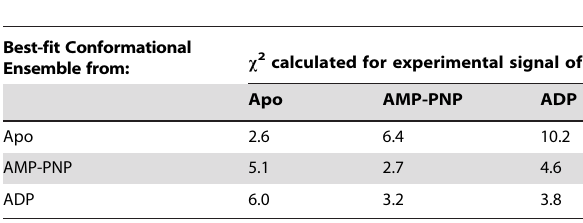
Table 1. Cross-calculation of conformational ensembles.